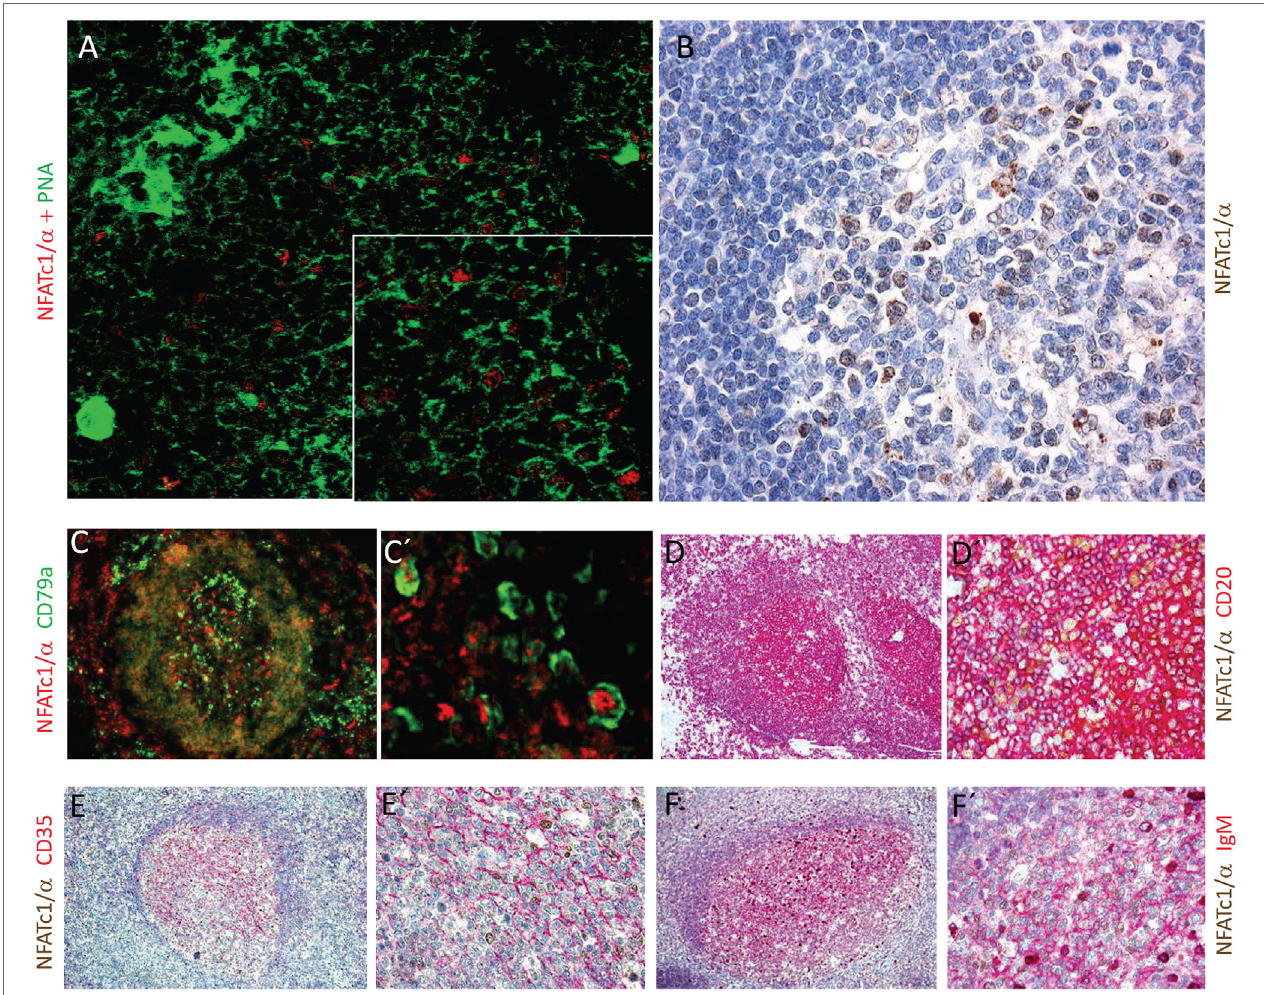
FigUre 5 | Nuclear expression of NFATc1/ α A in germinal center (GC) B cells. (a) Histochemical co-stains of GC cells with peanut agglutinin and an antibody (Ab) raised against the N-terminal α -peptide of NFATc1. A spleen section from a mouse immunized with sheep red blood cells for 7 days is shown. Magnification, 20-fold, and insert 40-fold. (B–F) Cross sections of tonsils from tonsilitis patients. (B) Co-stains of hematoxylin/eosin and an Ab specific for the NFATc1- α peptide. (c–F) Co-stains of NFATc1- α -specific Ab with Abs specific for CD79a (c,c ′ ) , CD20 (D,D ′ ) , CD35 (e,e ′ ) , and IgM (F,F ′ ) and at various magnifications (C vs. C ′ etc.) are shown. Magnifications are 20-fold (B) , 10-fold (c–F) , 40-fold (D ′ –F ′ ) , or 50-fold (c ′ )